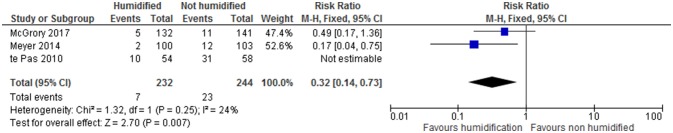
Admission temperature < 35.5°C.